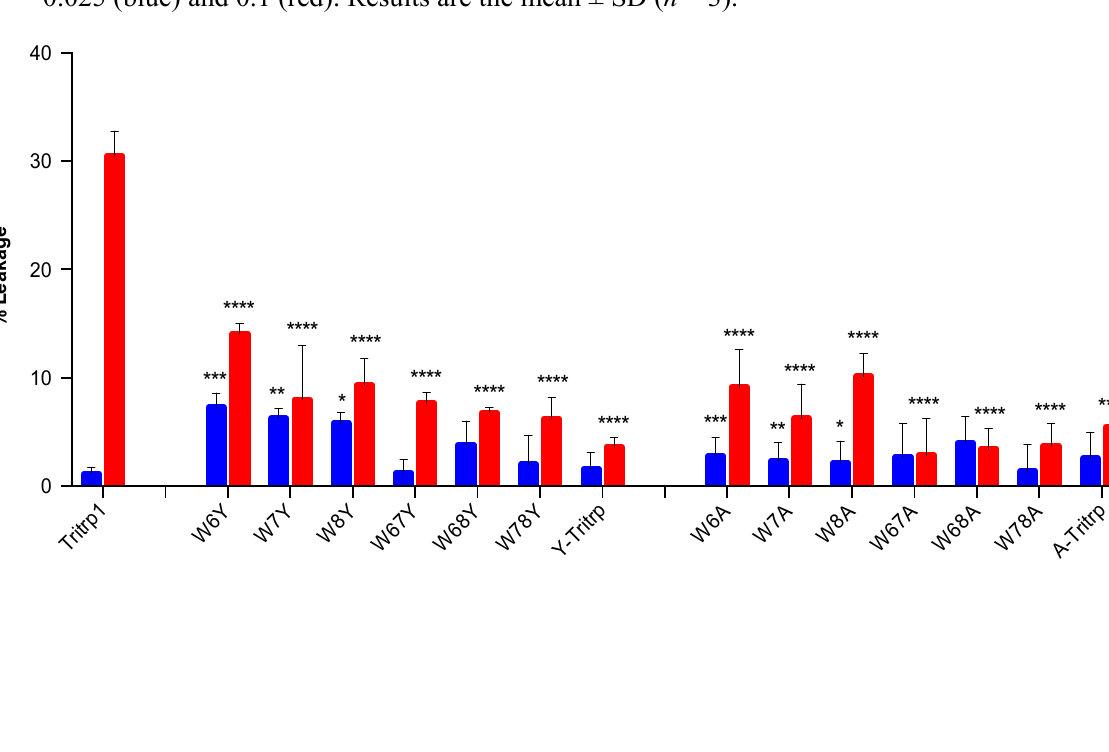
Figure 7. Calcein leakage results for Tritrp1 and its analogs in the presence of ePC:Chol (2.5:1) vesicles. Two different peptide/lipid (P/L) ratios are depicted as taken from Figure 6, 0.025 (blue) and 0.1 (red). Results are the mean ± SD ( n = 3).